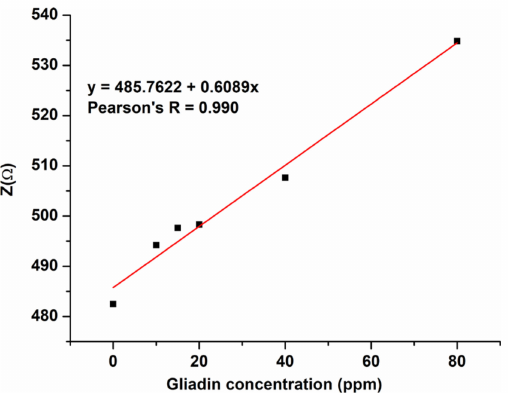
Figure 6. Change of impedance at 0.543 Hz as a function of gliadin concentration for TiNT GO antibody modified electrode in phosphate buffer.